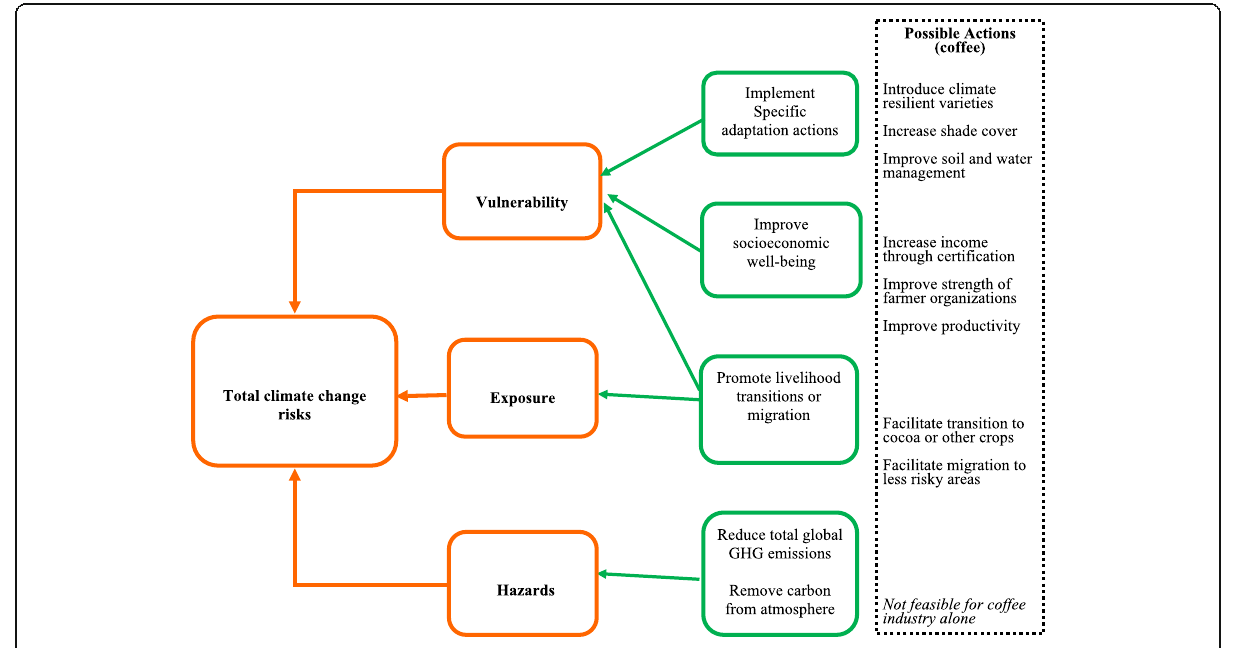
Fig. 2 Adaptation intervention pathways with possible coffee-specific